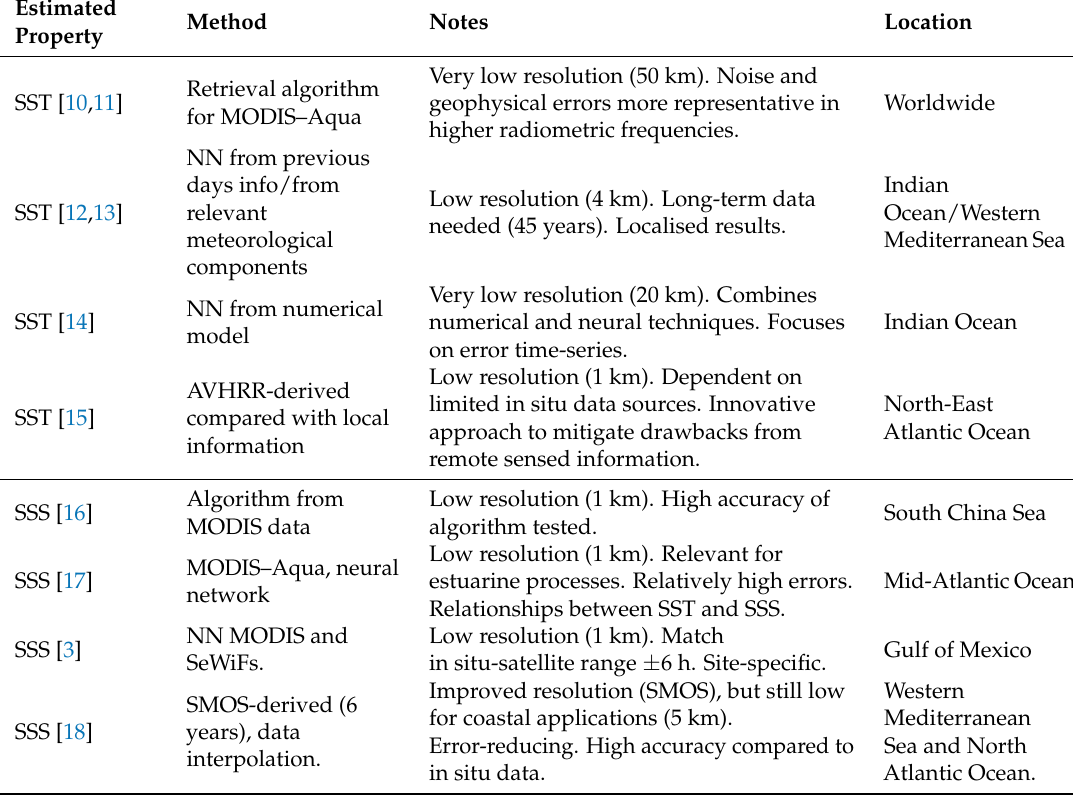
Table 2. Summary of satellite missions and projects used for SST and/or SSS estimation.